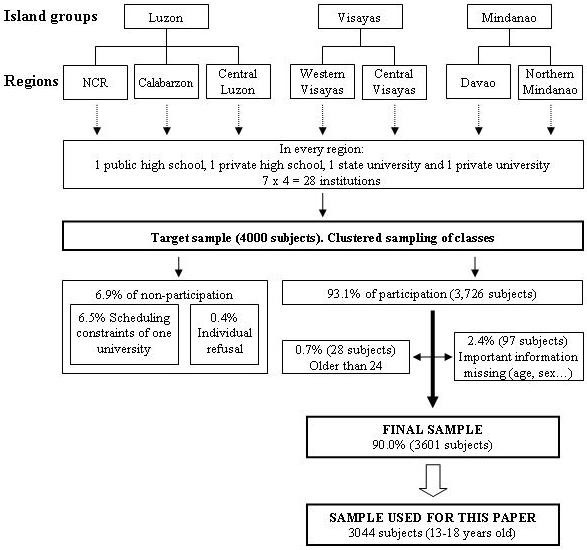
Sampling process.